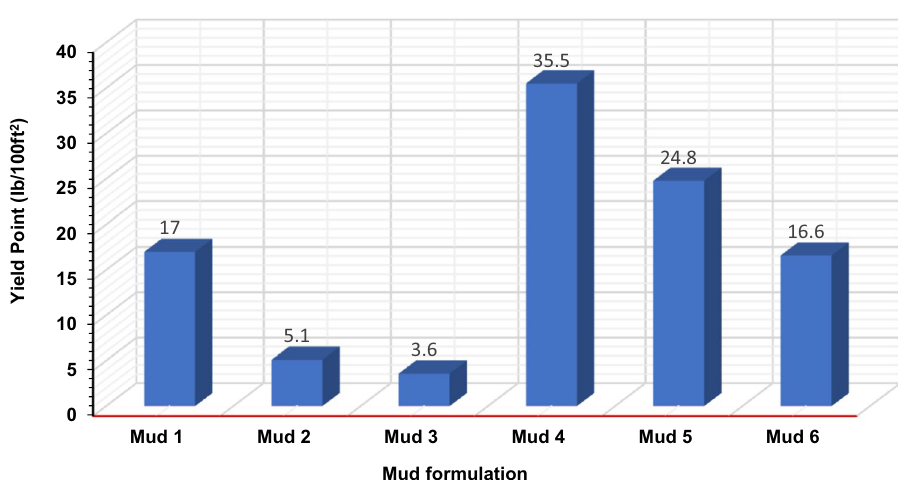
Fig. 10 Yield points of the drill- ing